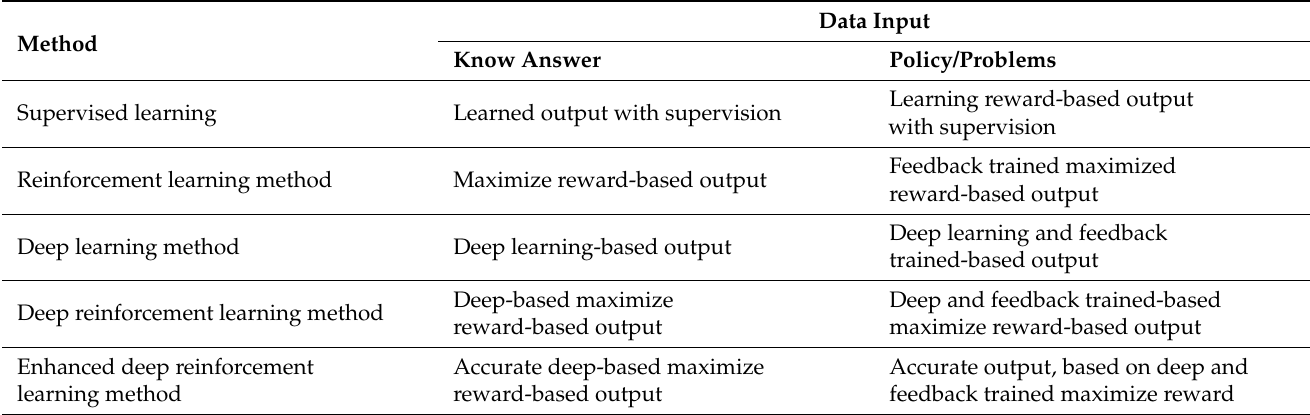
Table 2. Data input, policy relationship for types of ML and DL